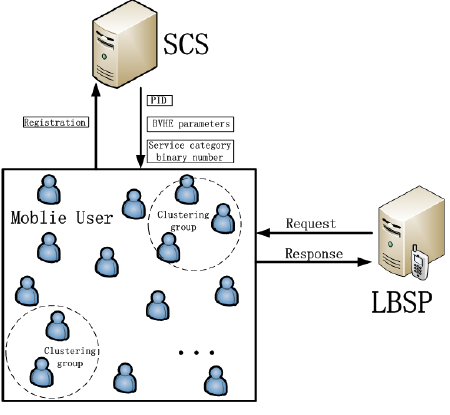
Figure 9. System